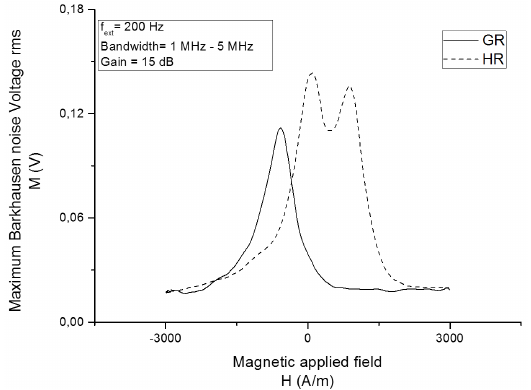
Figure 7. Correlation between FWHM values from XRD results and the maximum amplitude of the RMS of the Barkhausen noise